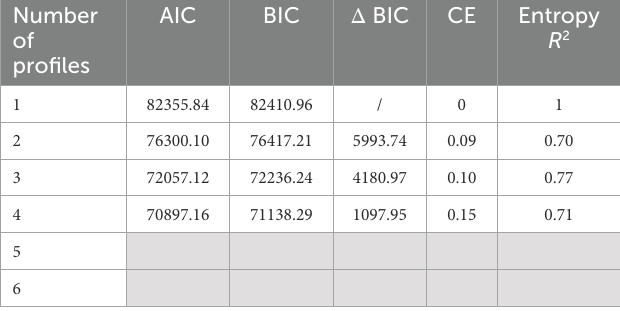
TABLE 2 Model fit statistics for the latent profile analysis for sample B (Spring). Number of